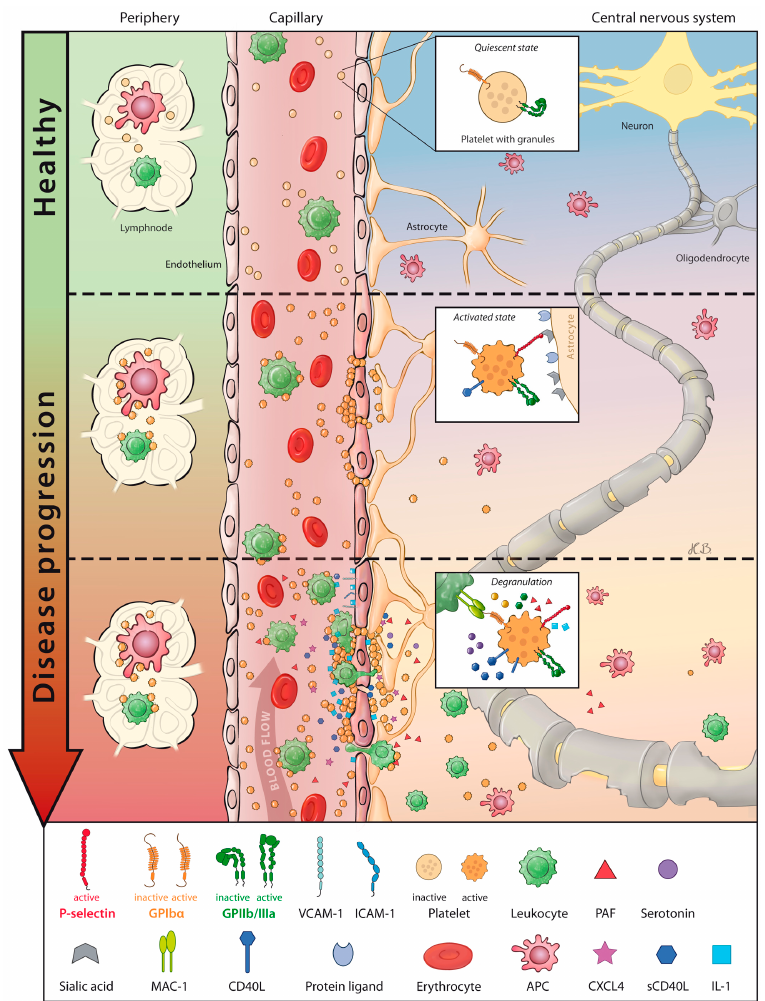
Figure 1. Platelet participation in pathophysiology of multiple sclerosis.